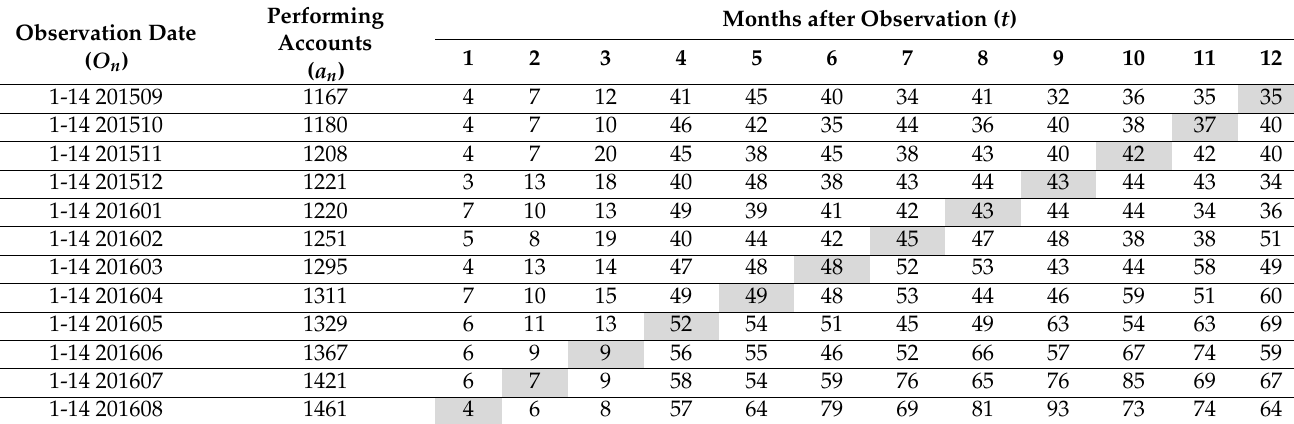
Table 1. Illustrative example of marginal